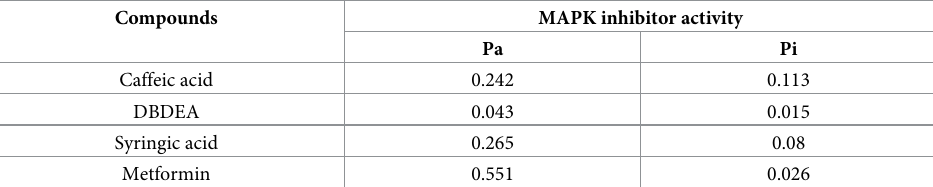
Table 6. PASS pharmacological activity prediction of experimental compounds.